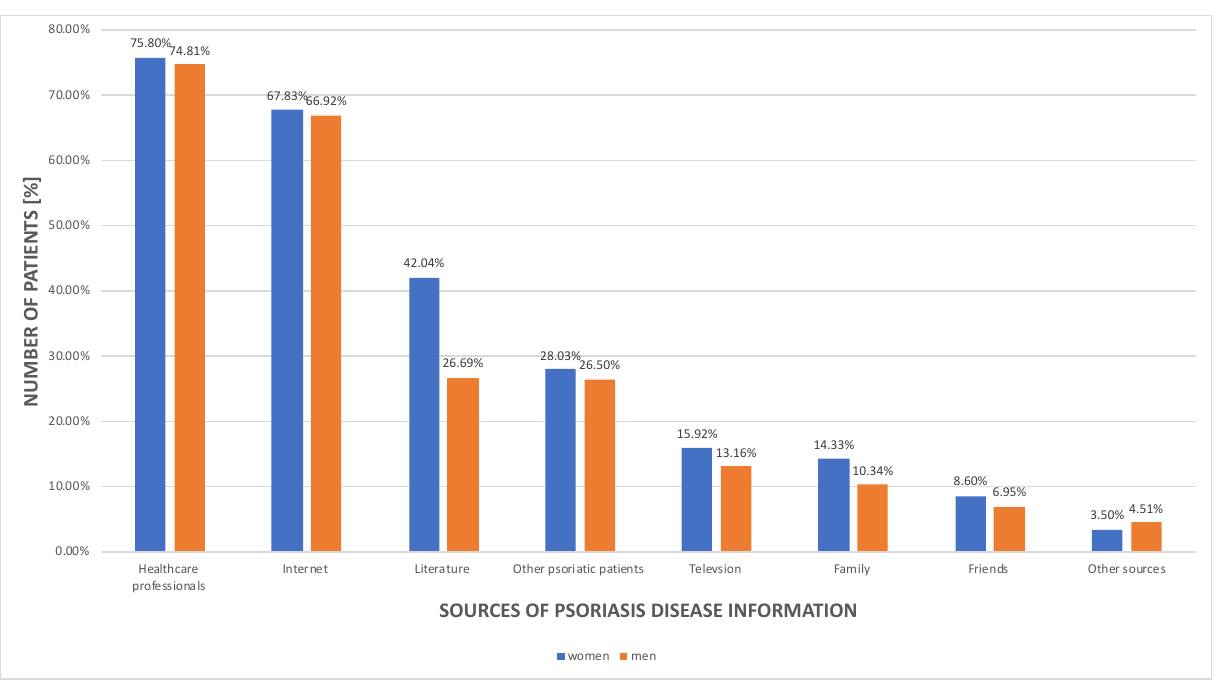
Figure 7. Analysis of the psoriatic patients’ choice of the disease information source.